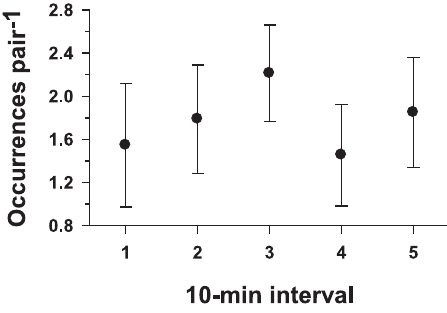
Figure 7. Absence of escalation of aggressive behaviors during the paired male encounters. Occurrences pair 2 1 (means 6 s.e.m.) of high-intensity aggressive behaviors ( hold and lunge , combined) through successive 10-min intervals within the encounters. Only the results for the day 3, 4, and 6 age cohorts are depicted because of the relative infrequency of these behaviors in the day 1 and 2 age cohorts.